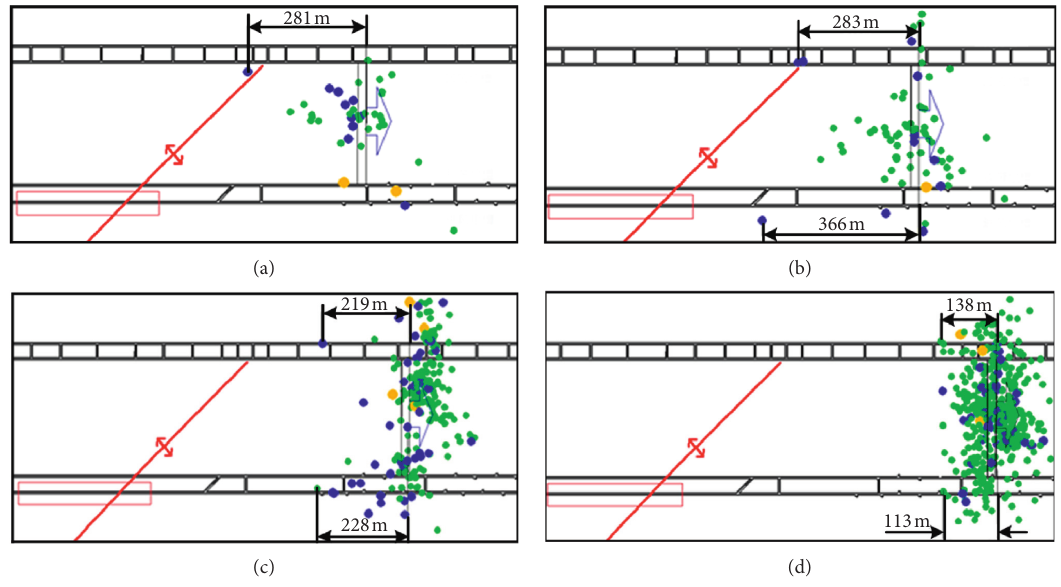
Figure 12: Projection of microseismic events at N2105 working